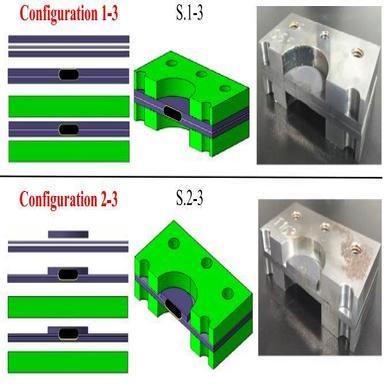
Loading configurations 1–3, 1–2 and 2–3.